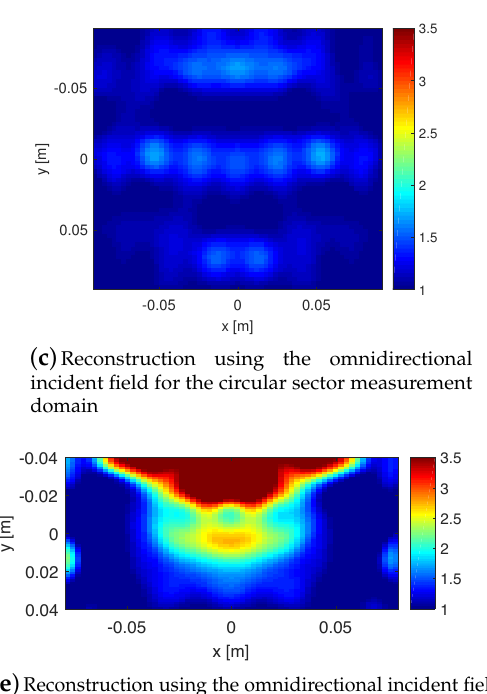
( f ) Reconstruction using the focused incident field for the circular sector measurement domain for the smaller imaging domain